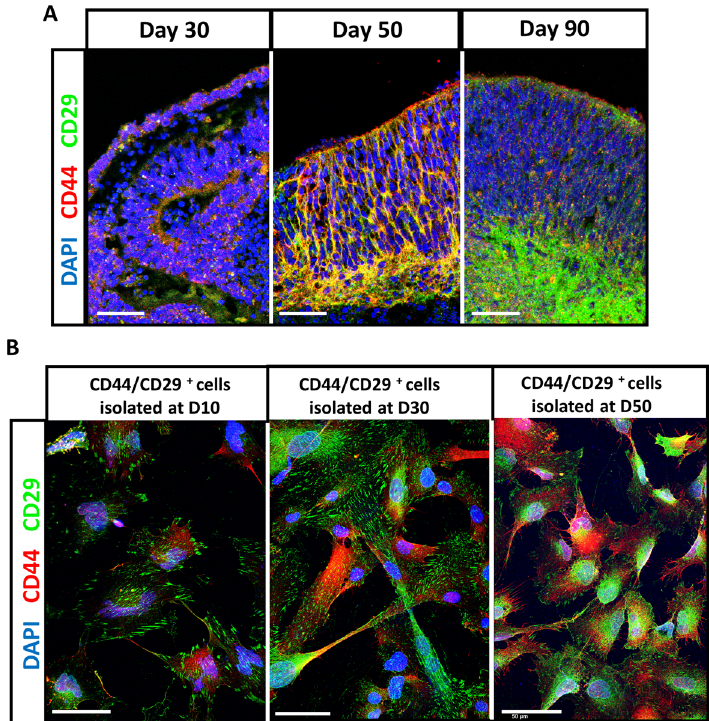
Figure 1. Isolation of CD29 + /CD44 + cells from retinal organoids. ( A ) Confocal images show positive staining for CD29 (green) in retinal organoids from days 20–70 after initiation of differentiation. ( B ) Representative confocal images show positive staining for CD29 (green), and CD44 in CD29 + /CD44 + cells isolated from day 10 (D10), 30 (D30) and day 50 (D50) organoids. Scale bar = 50 μm. Nuclei stained with DAPI